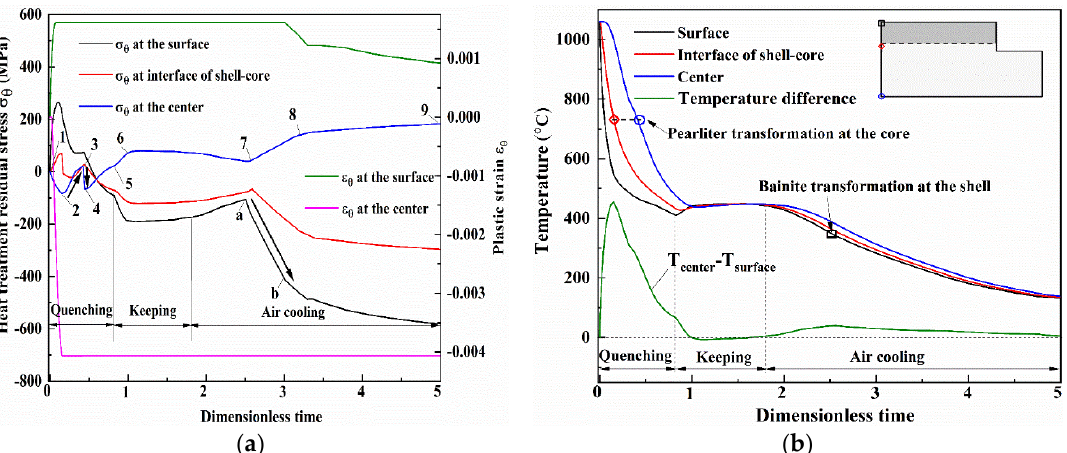
Figure 8. The histories of temperature and heat treatment residual stress at the surface, interface of the shell-core and the center of the work roll during the quenching process: ( a ) temperature and temperature difference between the roll surface and roll center; ( b ) heat treatment residual stress and plastic strain.